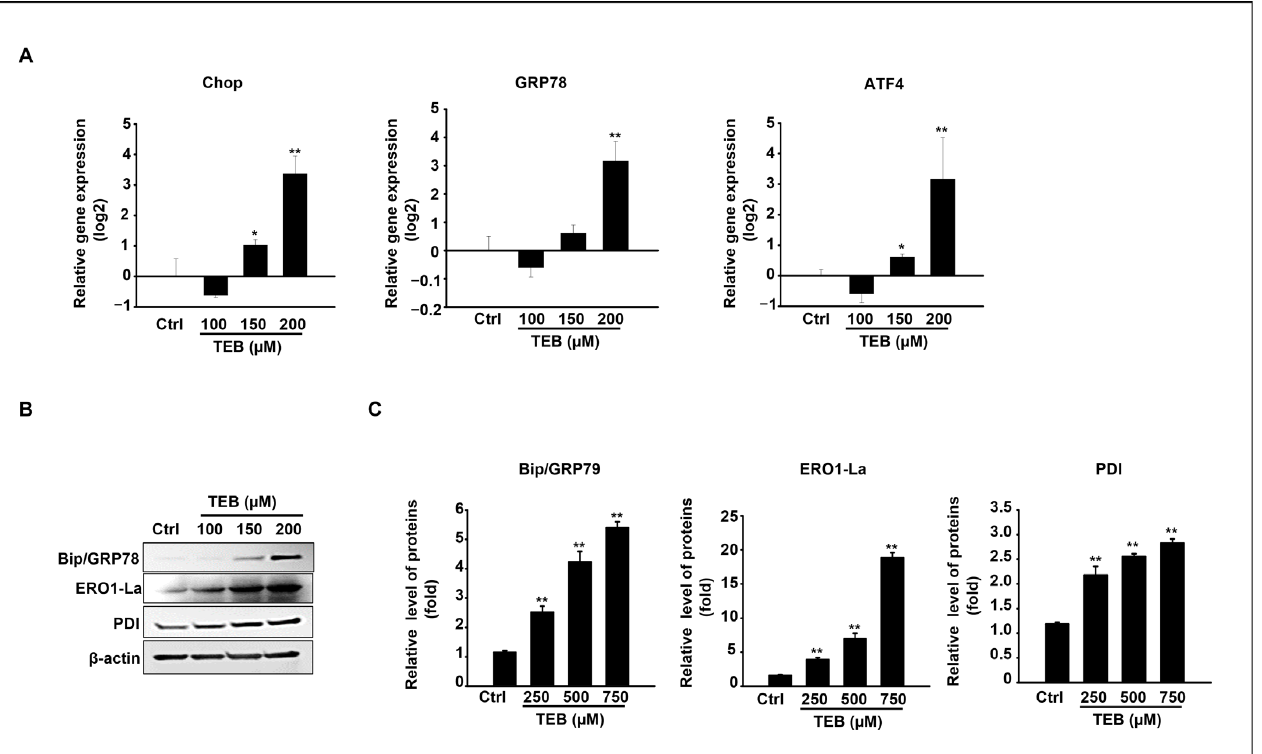
Figure 4. The expression of ER-stress-related genes and proteins in TEB-treated MAC-T cells. ( A ) mRNA expression levels of CHOP, Bip/Grp78, and ATF4 in MAC-T cells by qPCR after 24 h of TEB treatment. ( B ) Immunoblots for detecting Bip/Grp78, ERO1-L α, PDI, and β -actin in response to the exposure to different concentrations of TEB. ( C ) The graphs present the results of densitometric analysis. Each protein band was normalized using β -actin. Data represent the mean ± SD of three independent experiments (n = 3, * p < 0.05, and ** p < 0.001 compared to the controls).